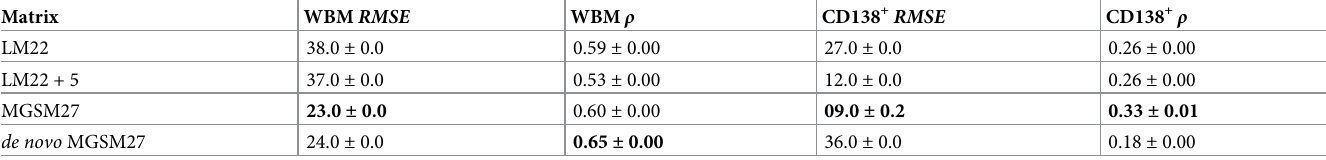
Table 1. Deconvolved tumor accuracy in WBM